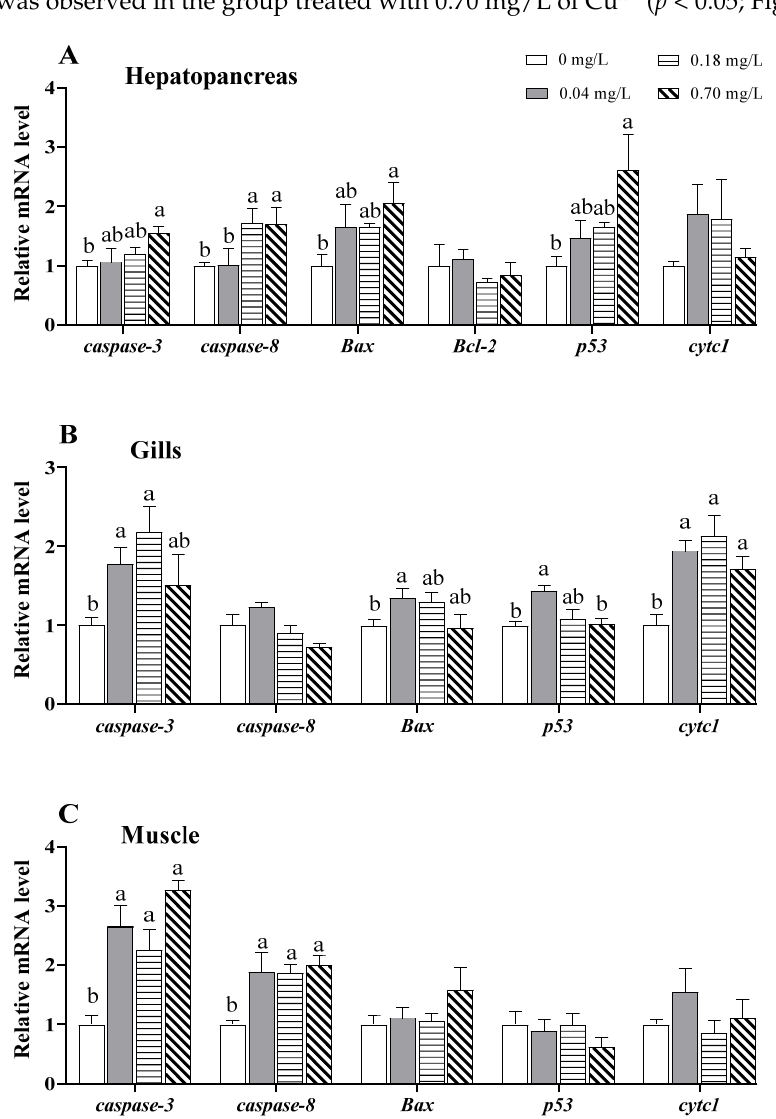
Figure 3. Expression of apoptosis-related genes in different tissues of E. sinensis exposed to copper for 5 days. ( A ) Hepatopancreas; ( B ) gills; ( C ) muscle. The values are expressed as the mean ± SEM ( n = 6). Different letters denote significant differences among different groups ( p < 0.05).